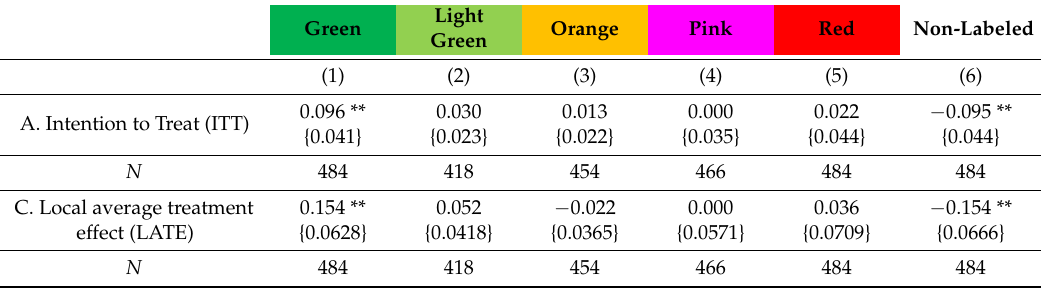
Table A3. ITT and LATE estimates of providing Nutri-Score Label information on the probability of purchasing at least one item of a particular color, using a Probit